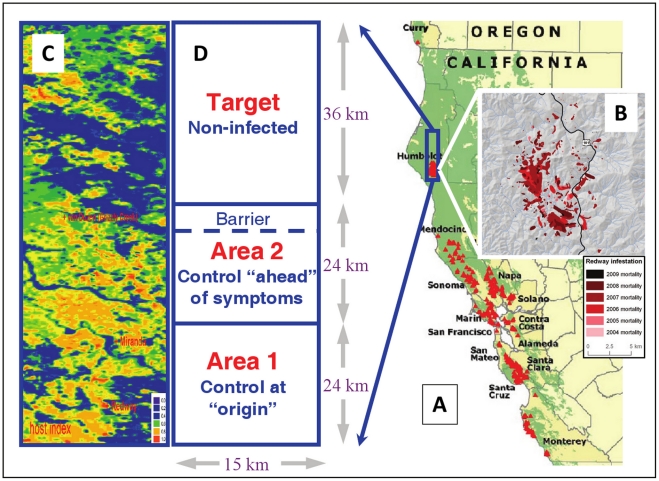
Study area, host, and mortality distribution in Humboldt County CA, USA.
A) Humboldt county is shown in reference to sudden oak death distribution in costal California in 2008. B) Distribution of overstory tree mortality between 2004 and 2009 determined from annual aerial surveys; these data were used to determine dispersal and other epidemiological parameters of the causative agent Phytophthora ramorum. C) Host index within the 15-by-84 km study area. Scale: <0.01 (purple), 0.4 (blue), 0.6 (green), 0.8 (yellow), 1.0 (red); darker areas are dominated by non-sporulating or non-susceptible hosts while yellow and red areas are primarily dominated by tanoak (Lithocarpus densiflorus). D) Disease control areas and objectives, and approximate location of the proposed barrier treatments.